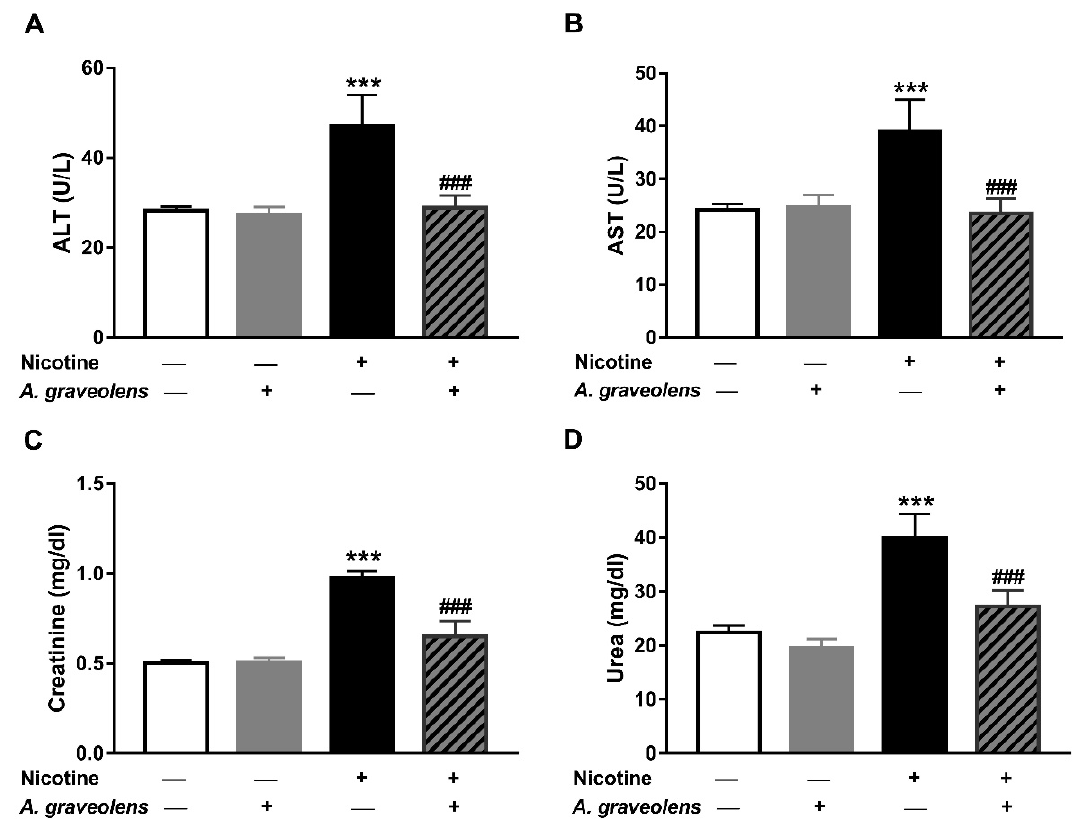
Figure 2. A. graveolens ameliorated serum aminotransferase (ALT) ( A ), aspartate aminotransferase (AST) ( B ), creatinine ( C ) and urea ( D ) in nicotine-exposed mice newborns. Data are mean ± standard error of the mean (SEM), n = 8. *** p < 0.001 versus Control and ### p < 0.001 versus nicotine.